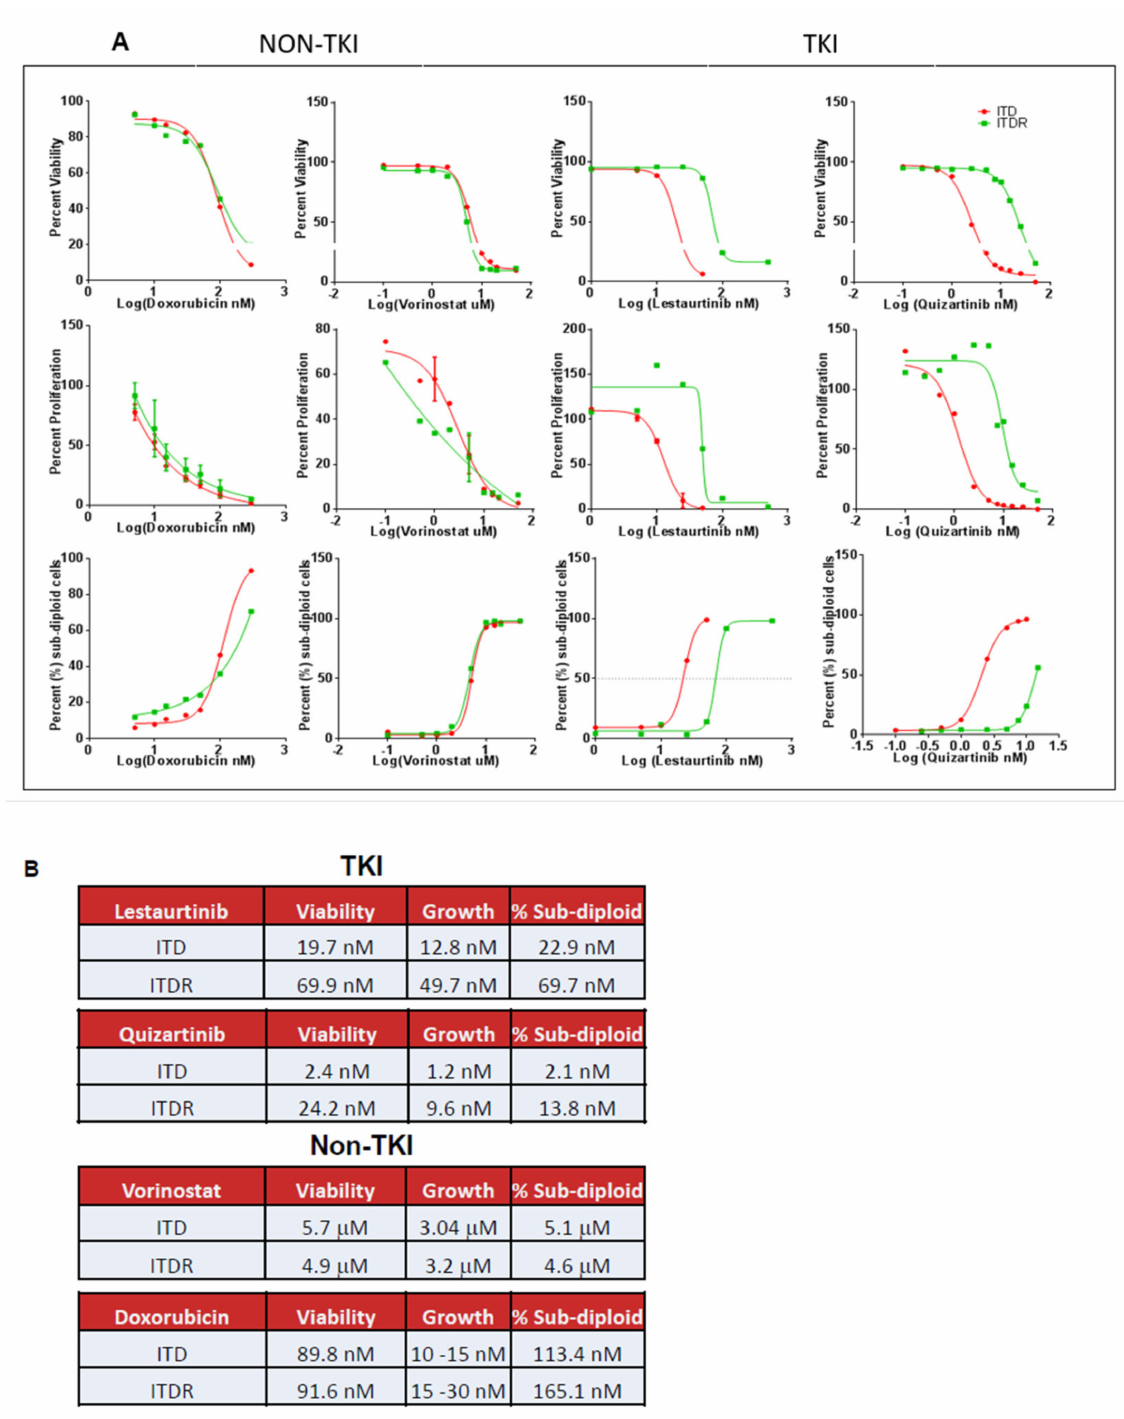
Figure 2. BaF3-FLT3-ITDR cells are pan-FLT3-inhibitor-resistant. ( A ) BaF3-FLT3-ITD and BaF3-FLT3- ITDR cells were treated with increasing doses of the FLT3-inhibitors lestaurtinib and quizartinib as well as the non-FLT3 inhibitors doxorubicin and vorinostat for 48 h. Proliferation and viability were measured using trypan blue exclusion and counting via ViCell analyzer. Cells were also stained with propidium iodide and measured on the FL-3 channel of a FACScaliber flow cytometer. ( B ) IC 50 values were calculated based on viability, growth, and sub-diploid (PI) analyses using GraphPad Prism for BaF3-FLT3-ITD and BaF3-FLT3-ITDR